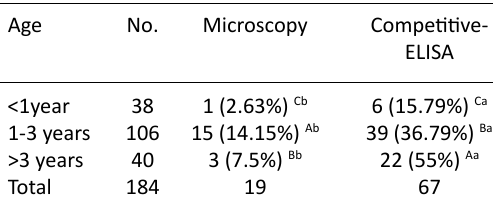
Table 5. Association of positive A. marginale infections to sex factor Sex No. Microscopy Competitive- ELISA Female 161 18 (11.18%) Ab 63 (39.13%) Aa 1 (4.35%) Bb 4 (17.39%) Ba Total 184 19 67 Variation in large vertical and small horizontal letters refers to significant